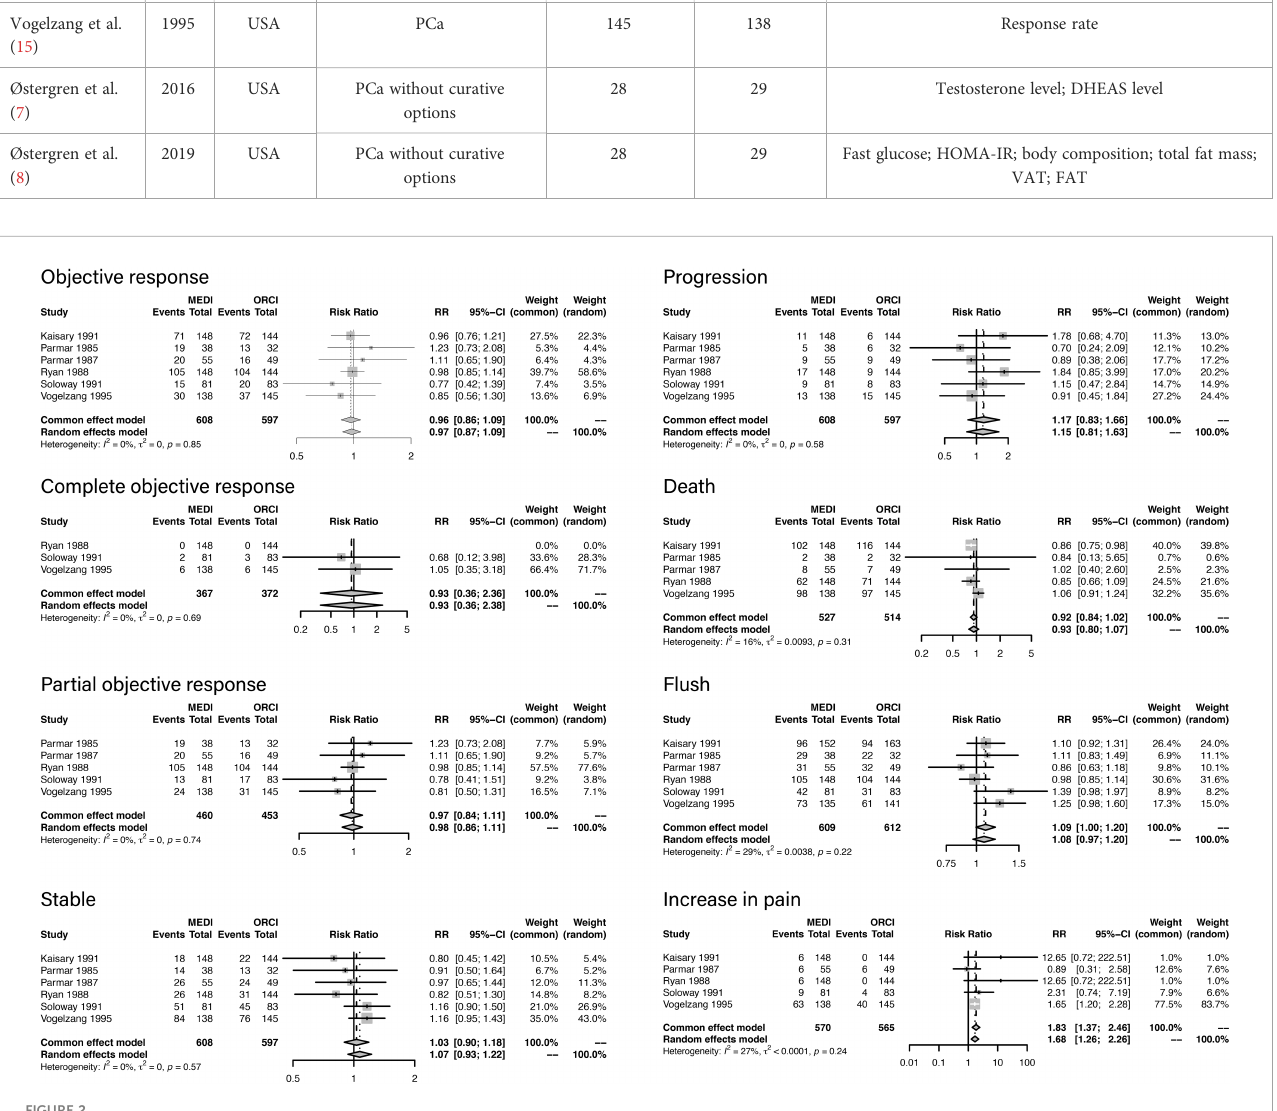
FIGURE 2 Forest plots of